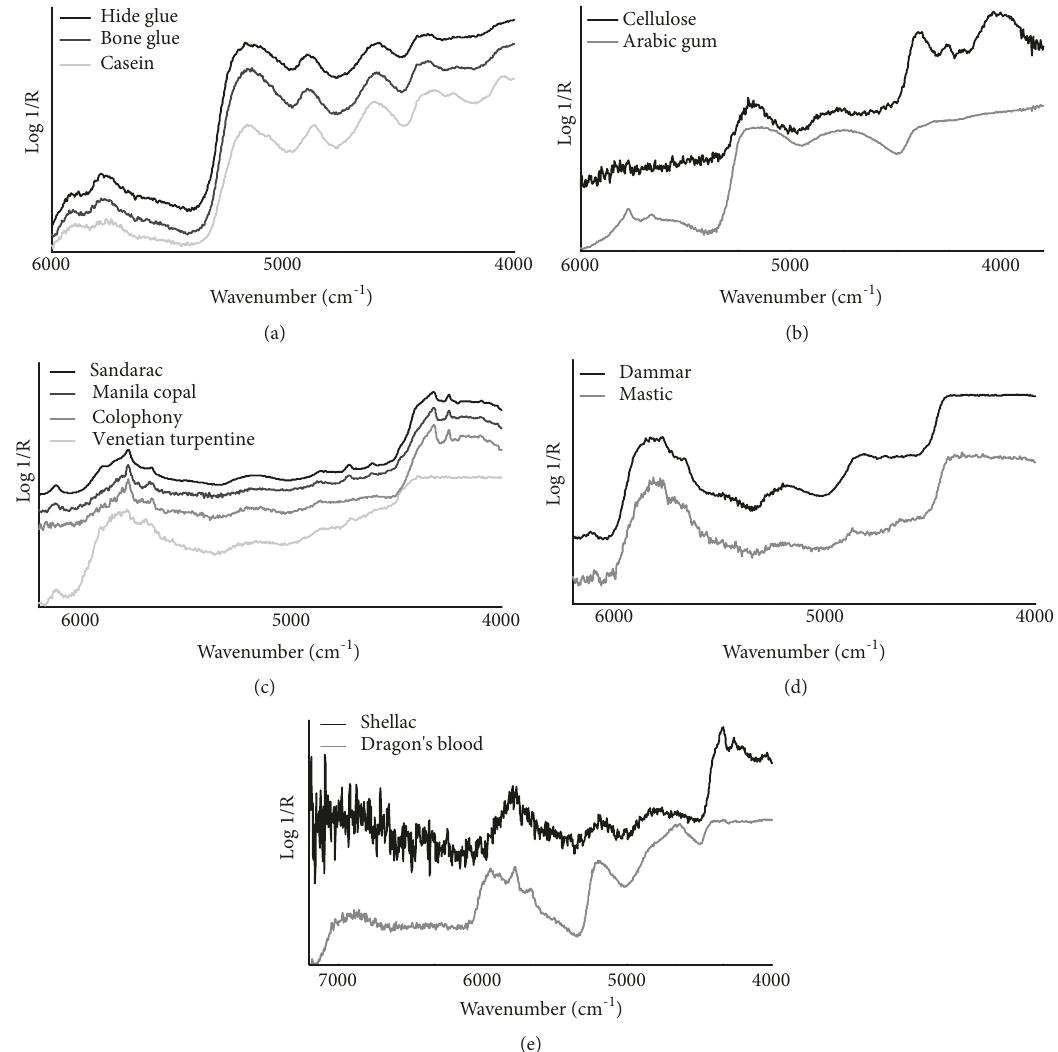
Figure 2: FTIR total reflection mode spectra in the near-infrared region of the studied (a) proteinaceous materials, (b) polysaccharide materials, (c) diterpenoid resins, (d) triterpenoid resins, and (e) not (exclusively) terpenoid-based